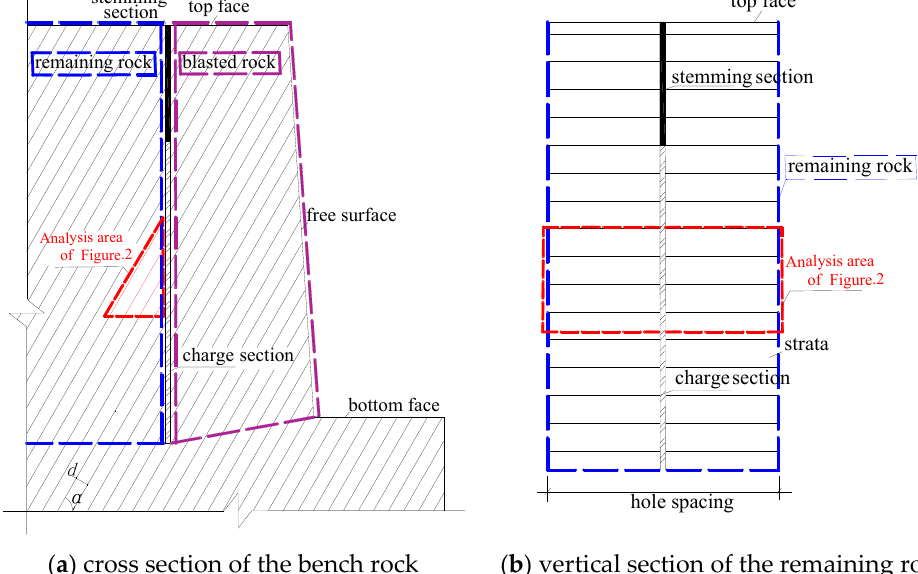
Figure 1. Different sectional view of bench blasting in the dipping-in-face rock stratum.